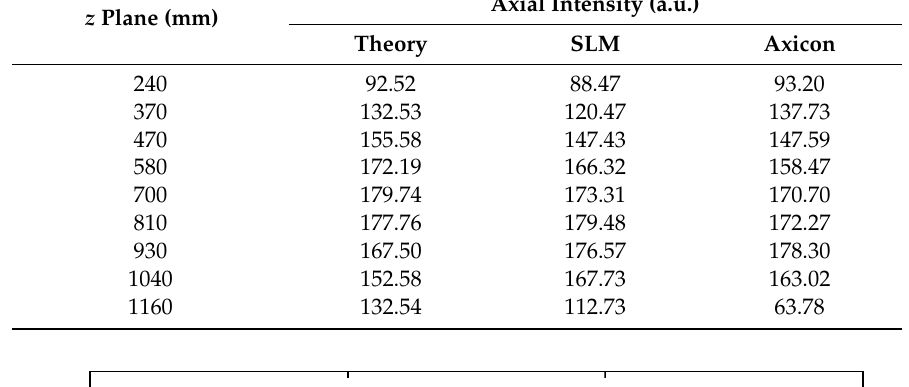
Table 1. Axial-intensity distributions of Bessel beams of theory generated by the SLM and the real axicon.